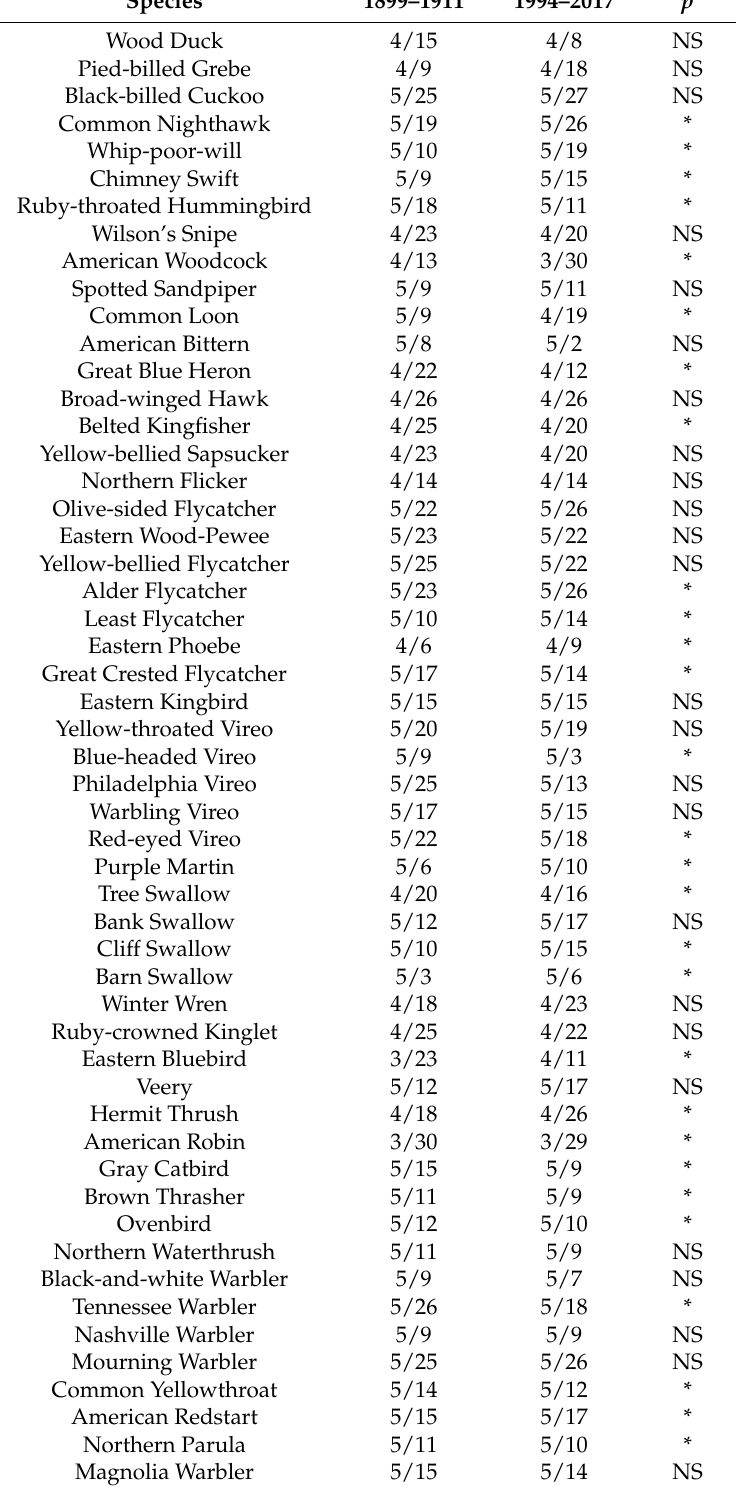
Table 3. Comparison of mean arrival date between the early period of 1899–1911 (data from Journal of Maine Ornithological Society) and the recent period of 1994–2017 using the present data. To control for false discovery rates because of multiple comparisons, the Benjamini-Hochberg corrected was applied [17]. Asterisks indicate significant differences ( p < 0.05) after